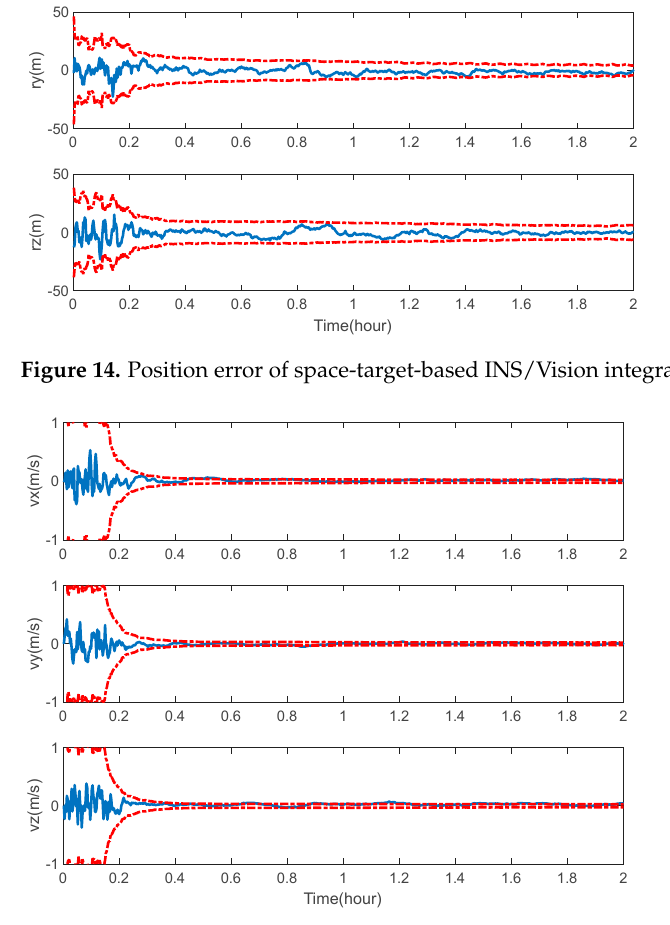
Figure 15. Velocity error of space-target-based INS/Vision integrated navigation.